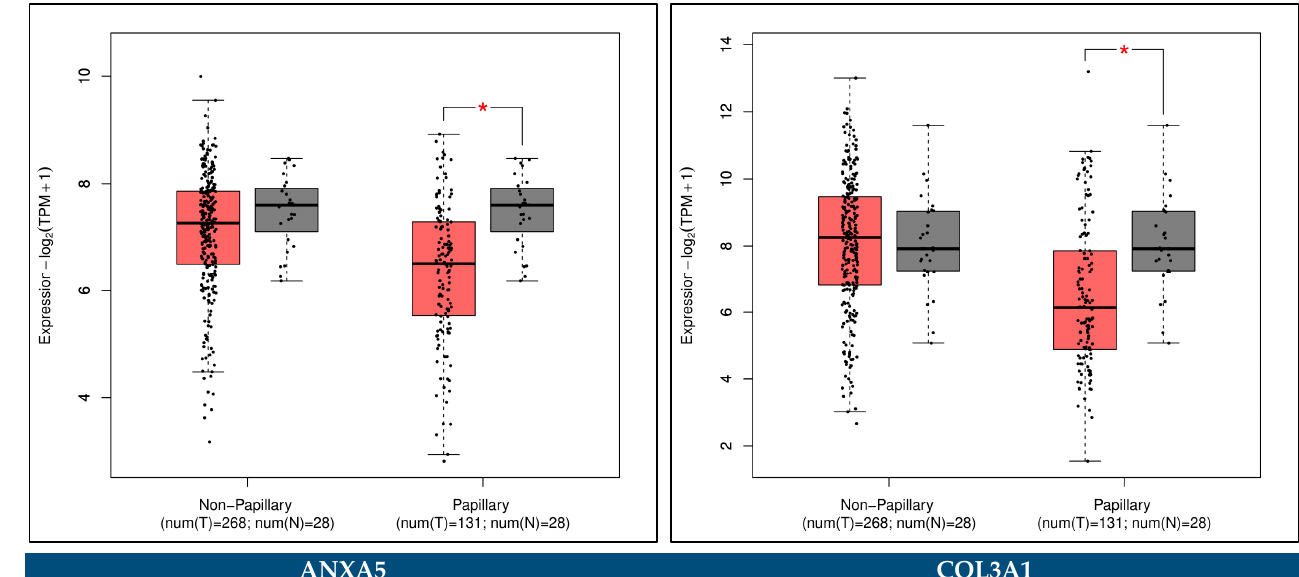
Figure 26. The gene expression level analysis of the ANXA5 and COL3A1 in BCa patients for non- papillary and papillary subtypes, generated using the GEPIA2 platform. The red boxes represent the mRNA expression levels in BCa subtype tissues and the gray boxes represent the expression levels in control bladder tissues from patients of the TCGA-BCa and GTEx cohorts. * indicates statistical significance applying p -value < 0.05 and |log 2 FC| < 1 as cut-off criteria (TPM: transcript count per million).